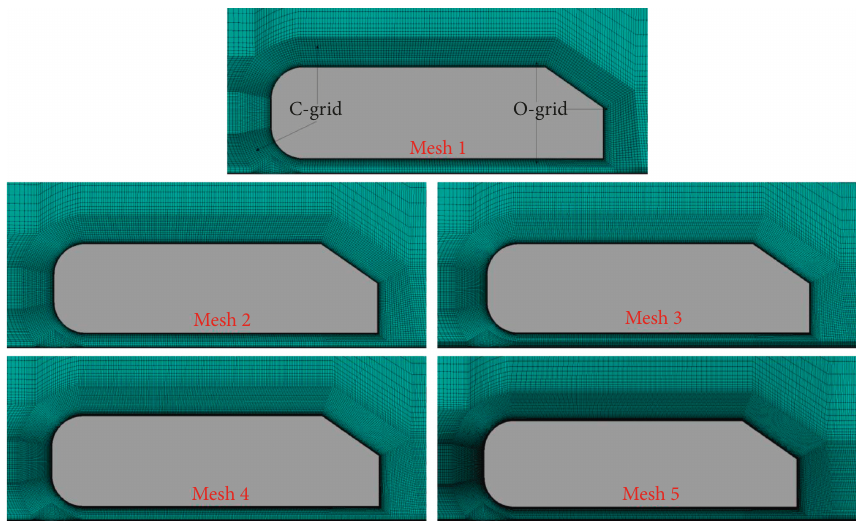
Figure 4: Schematic diagram of five sets of grids on the xz symmetry Table 1: Mesh independence verification.